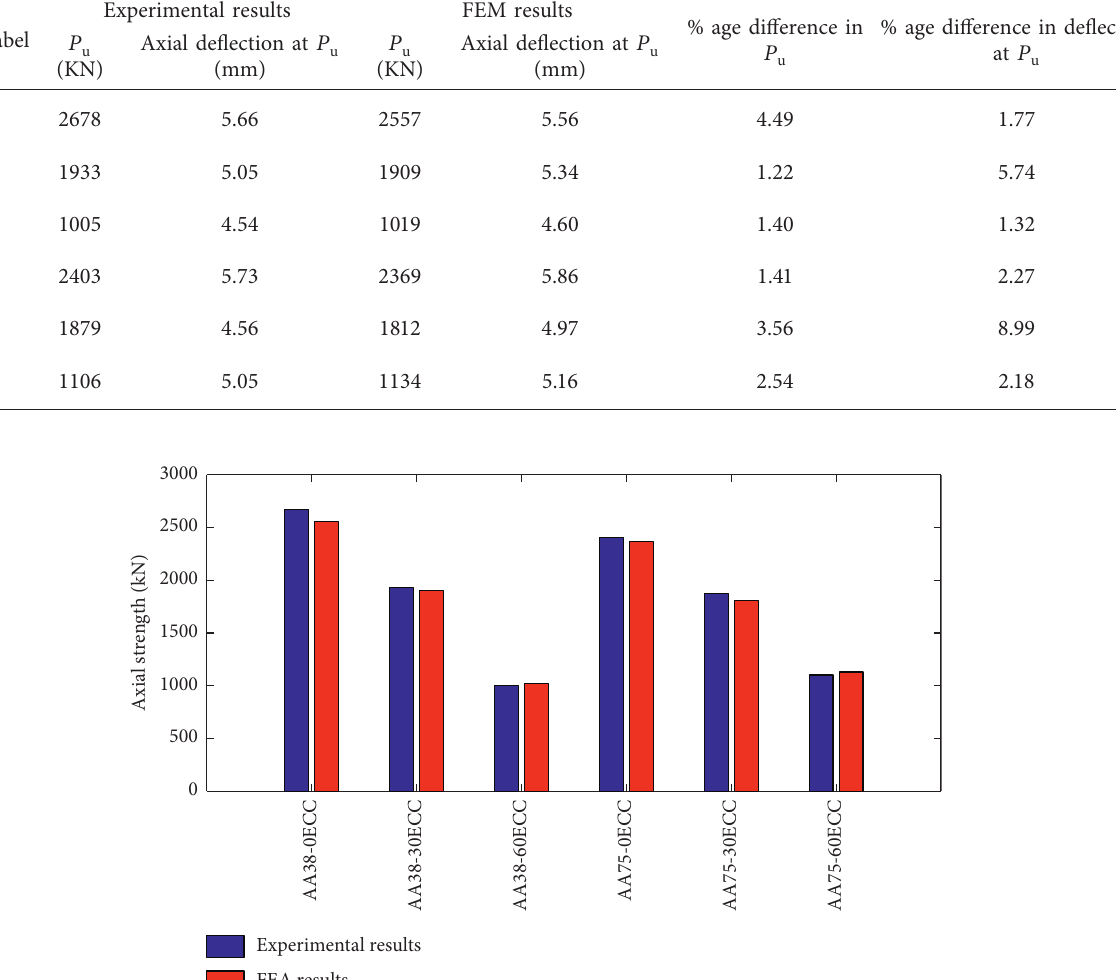
) and axial deflection at P u